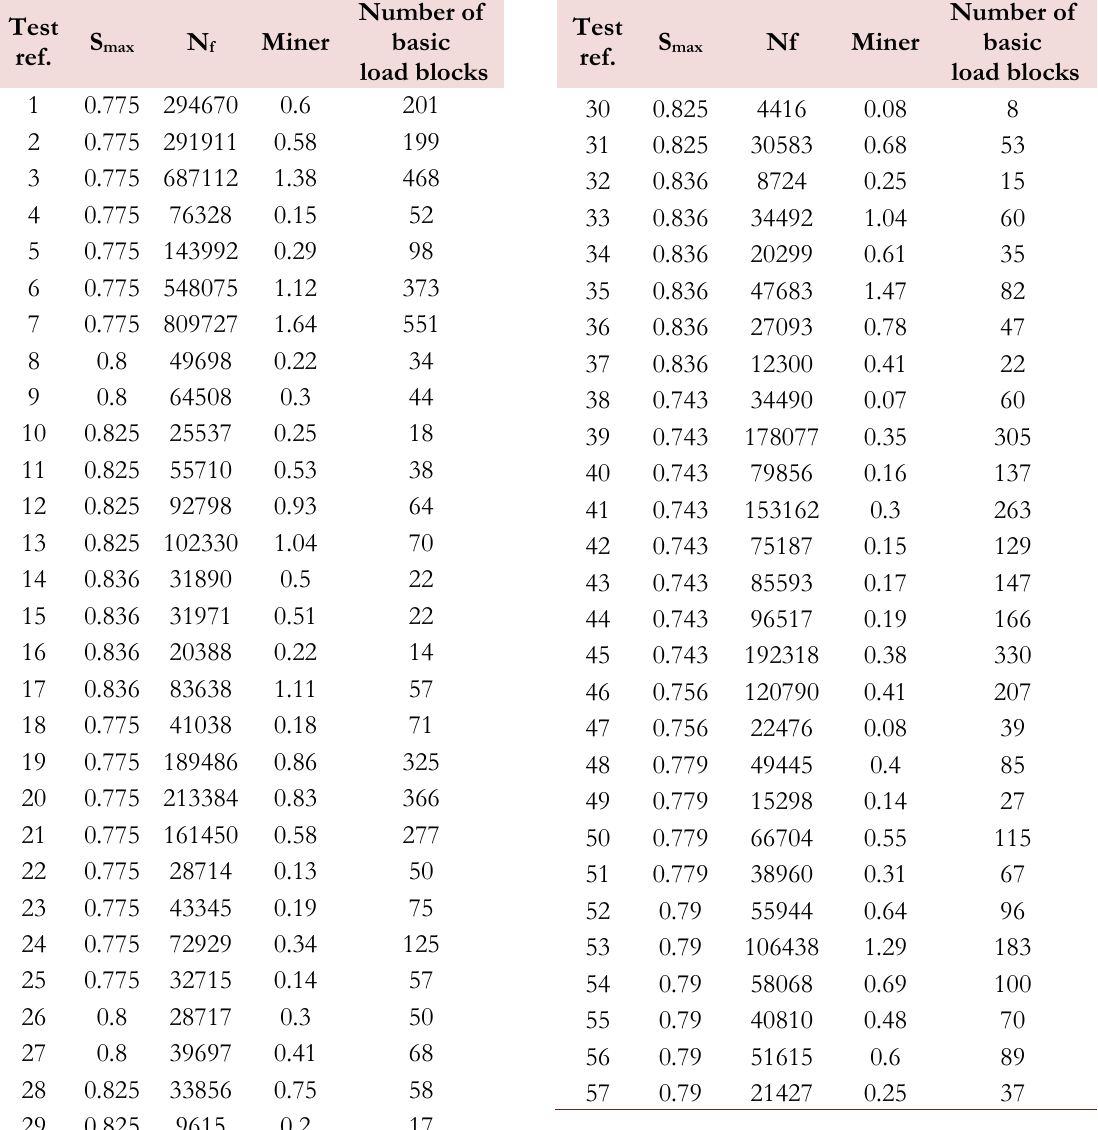
Table 3: Number of total cycles N applied until failure, experimental Miner numbers resulting from the Holmen’s variable loading f tests and corresponding number of replications of the basic stress blocks necessary to achieve